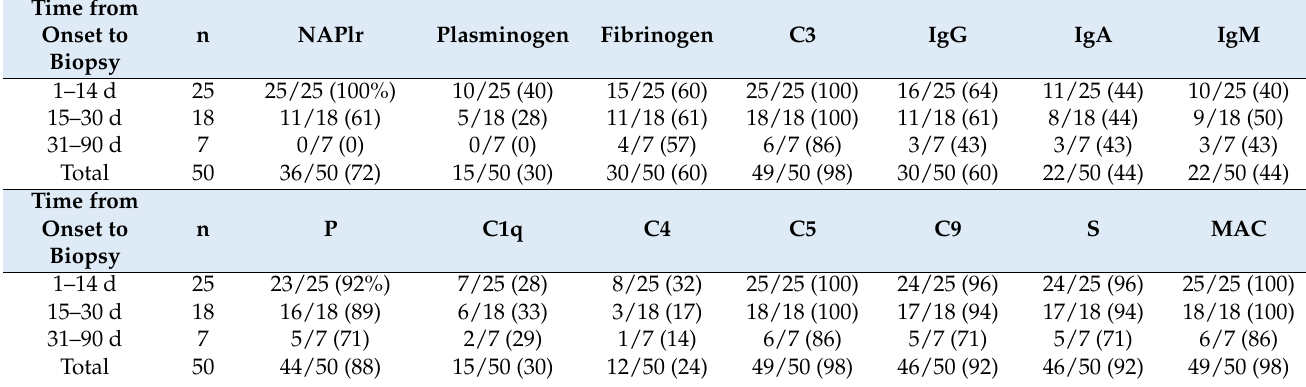
Figure 3. Two different patterns of glomerular C3 and IgG deposits in post-infectious glomeru- lonephritis. ( A , B ): C3 with IgG deposits, positive granular staining for C3 ( A ) and for IgG ( B ). ( C , D ): C3 without IgG deposits, positive granular staining for C3 ( C ) but completely negative staining for IgG ( D ). Original magnification: × 400. Photographs are cited from a previously published report [22]. Table 1. Immunofluorescence studies in patients with PSAGN.